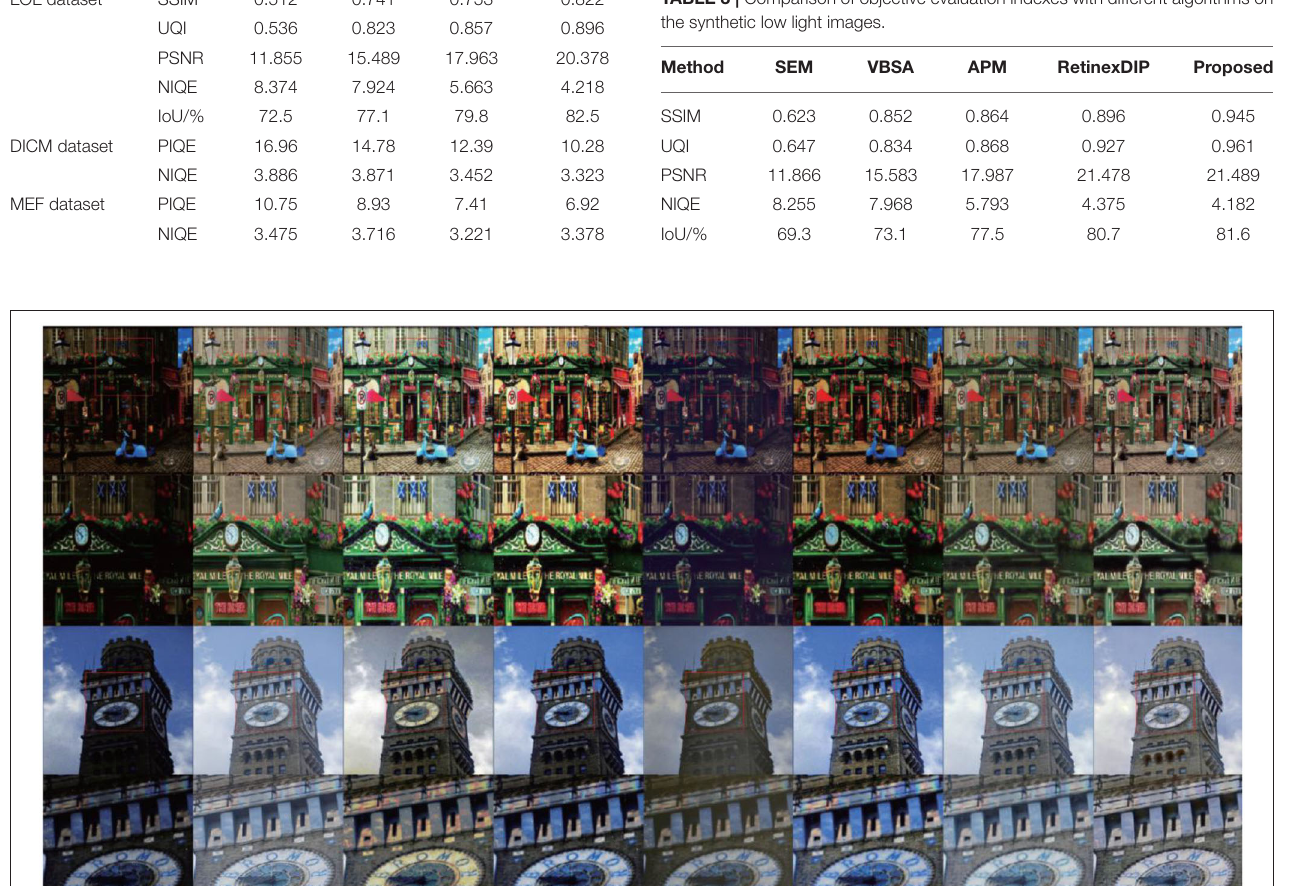
Frontiers in Neurorobotics |